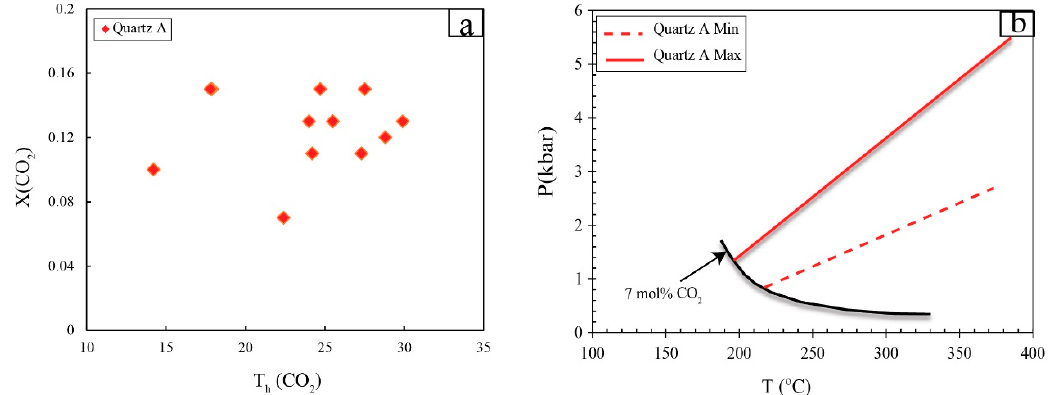
Figure 14. ( a ) Relationship between homogenization temperatures of CO 2 –Th(CO 2 ) and amount of CO 2 fraction–X(CO 2 ) for Type IIIb aqueous-carbonic fluid inclusions. ( b ) The P–T diagram of isochores plotted for Type IIIb aqueous-carbonic fluid inclusions of ρ min and ρ max intersected by isopleth of 7 mol% CO 2 .